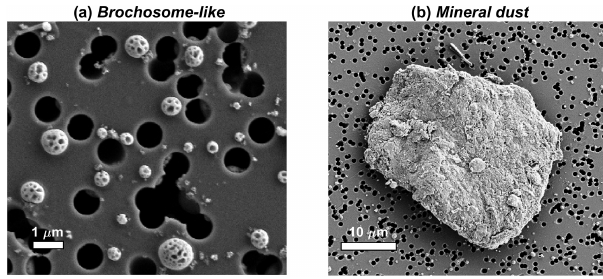
Figure 5. Scanning electron microscope images of brochosome-like particles (a) and mineral dust (b) collected during the same period as the Atlantic-1 MSD